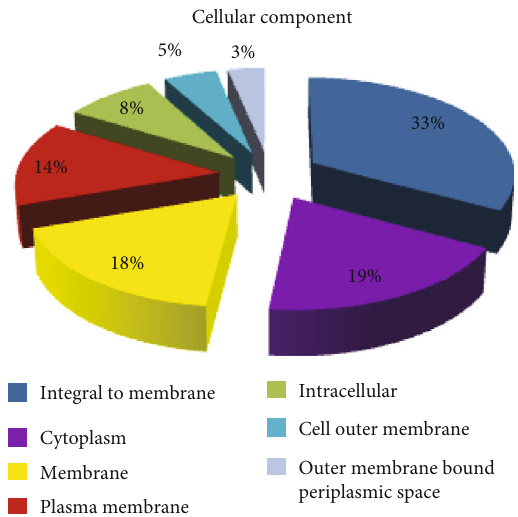
Figure 9: Gene Ontology (GO) distributions for reniform nematode genomic sequences as determined by Blast2GO and grouped by cellular component for the SIGMA library.